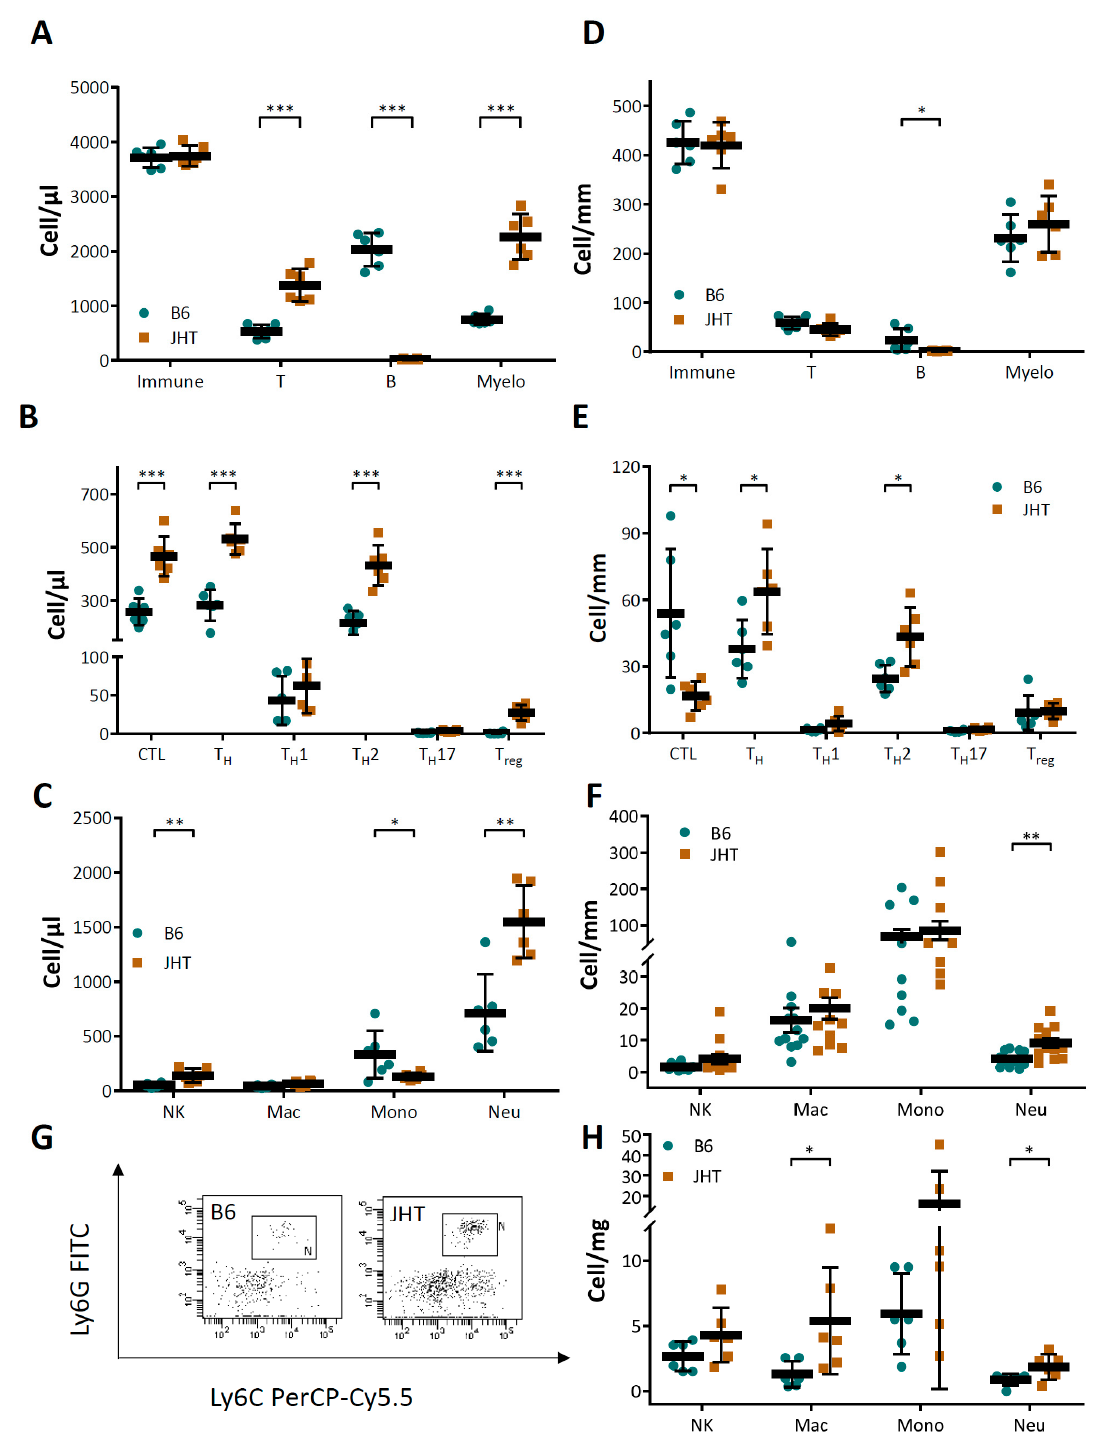
Figure 3. B cell-deficiency in mice leads to neutrophilia and neutrophil infiltration in aortic tissues. Immune cell profile was analyzed with FACS using blood ( A – C ), aorta ( D – F ), and aortic PVAT ( G , H ) samples from 17-week-old wild-type C57BL/6J and B cell-deficient JHT mice, respectively. The horizontal lines in the scatter dot plots represent mean ± SD. * p < 0.05, ** p < 0.01, *** p < 0.001; unpaired t -test.